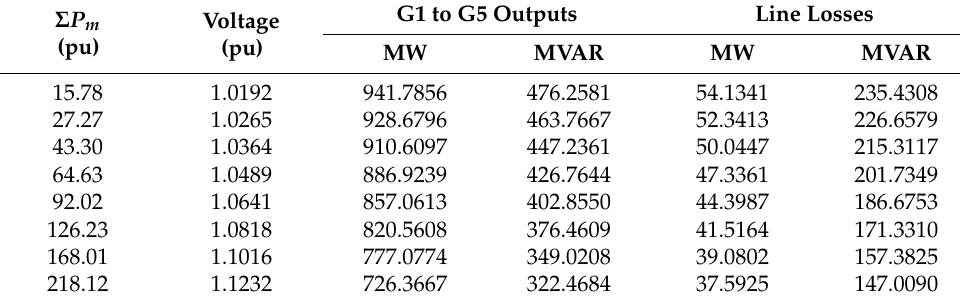
Table 12. WPP voltages, G1 to G5 power outputs and line losses (PF = 0.95 leading).